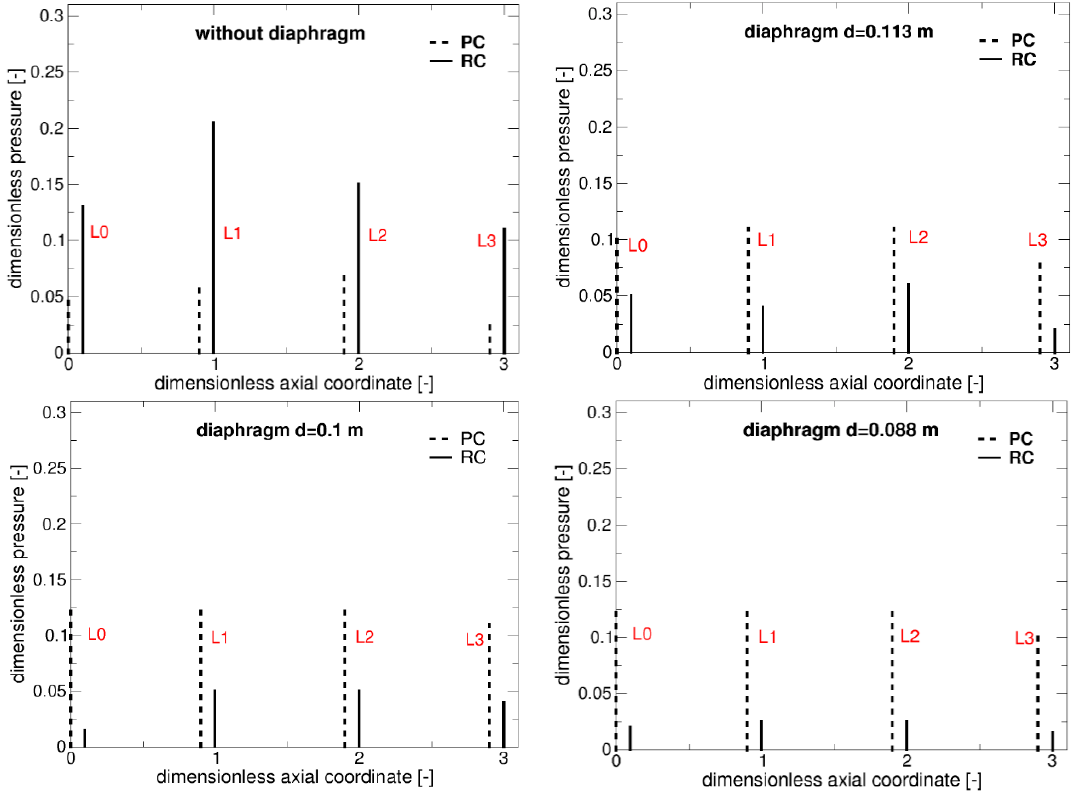
Figure 10. Rotating—RC (asynchronous) and plunging—PC (synchronous) components along to the cone wall for the cases without the diaphragm and with diaphragm area ratios of 50% (d = 0.113 m), 60% (d = 0.1 m) and 70% (d = 0.088 m), respectively.